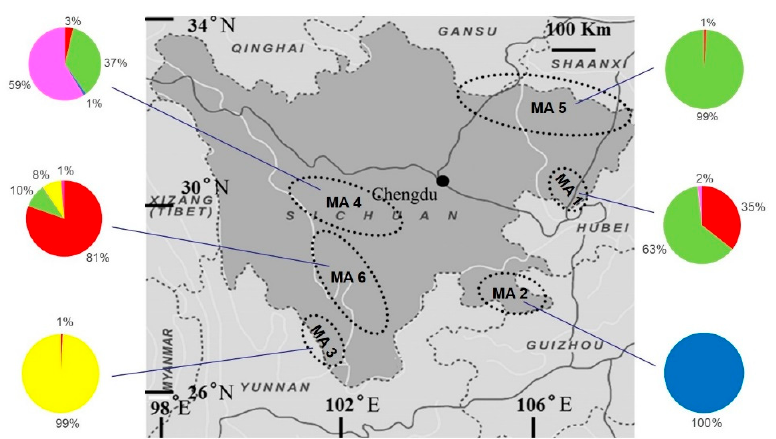
Figure 3. Map of Sichuan Province with the six main mountain areas (MAs) marked. MA 1 to MA 6 are the six origin areas of 37 plants of F. nilgerrensis . Pie charts represent membership coefficients for K = 5 calculated by STRUCTURE averaged by mountain areas for plants of F. nilgerrensis collected in Sichuan province.